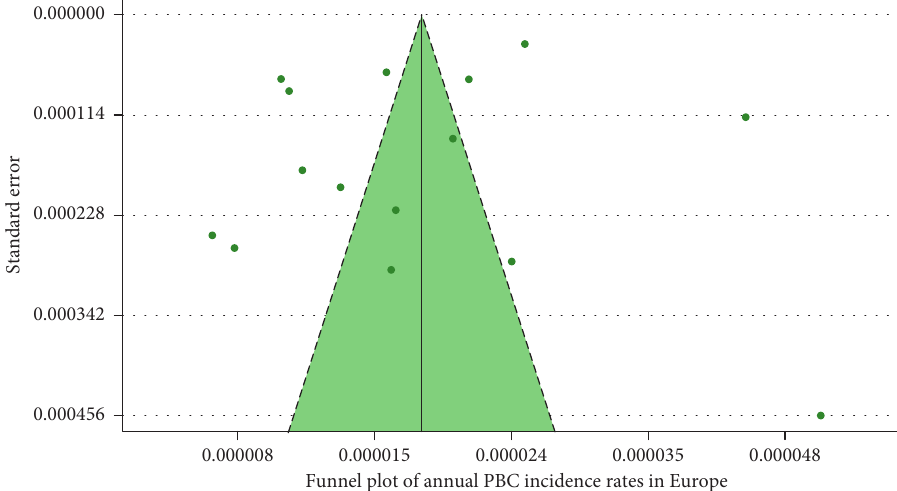
Figure 9: Funnel plot of annual PBC incidence rates in Europe.